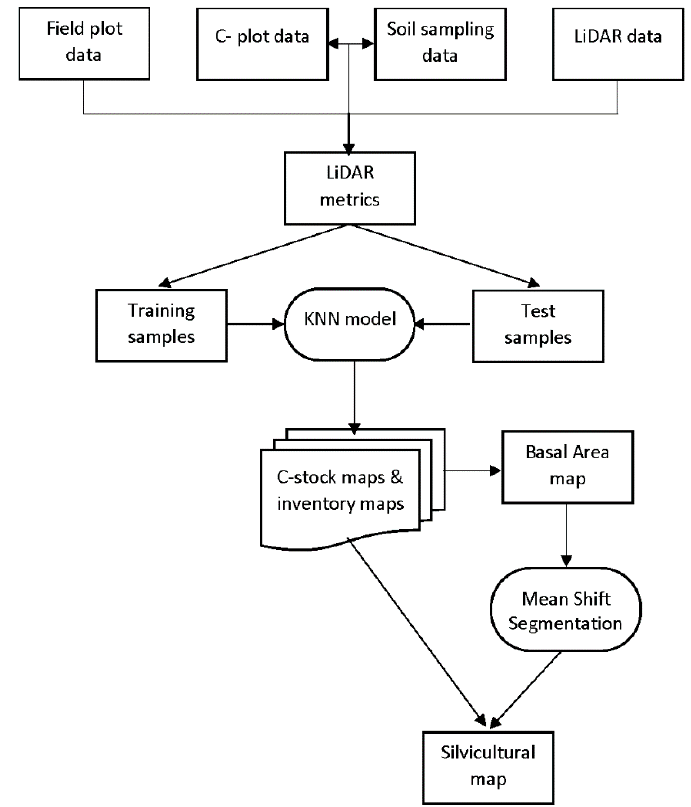
Figure 1. Flowchart describing the methodological steps to assess on-site carbon stocks using low density ALS data.